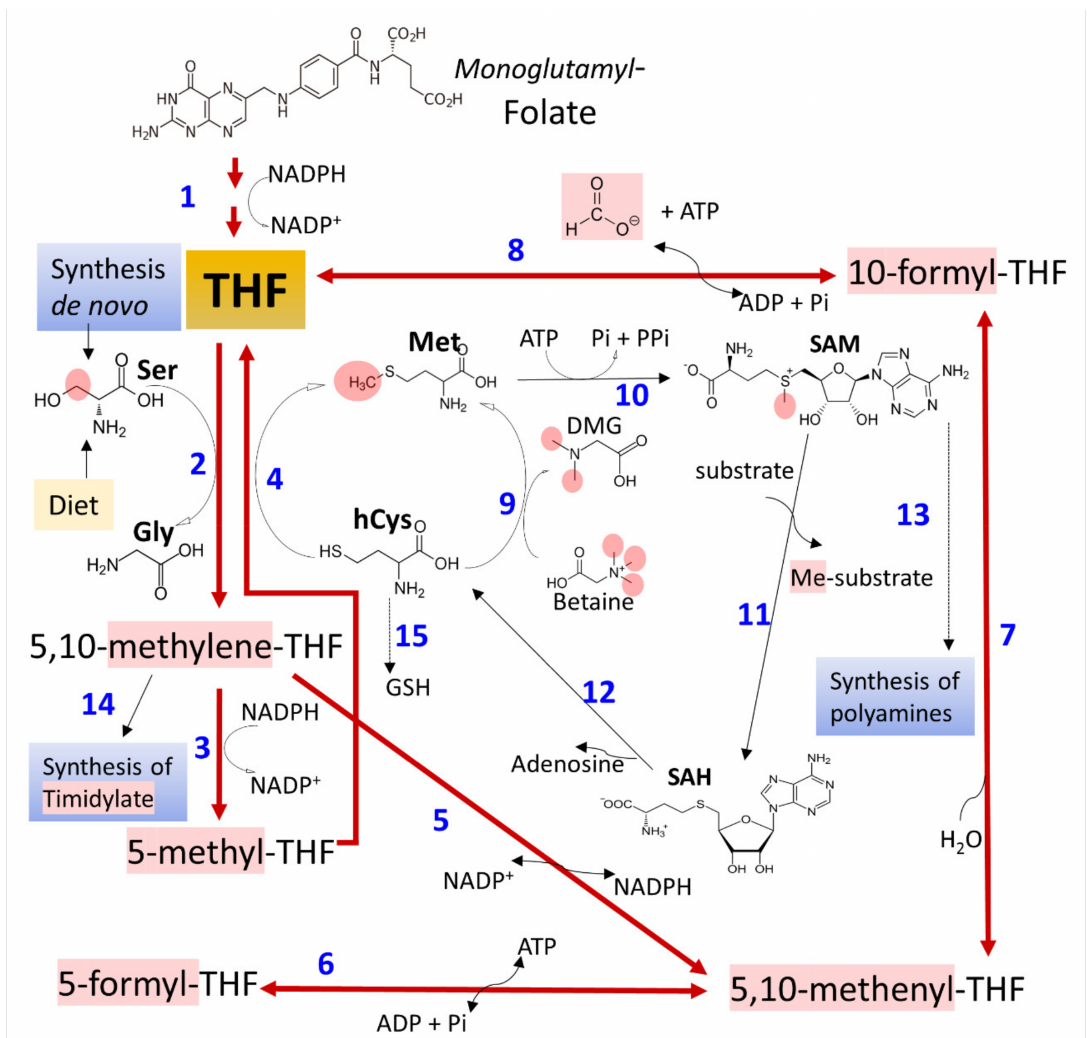
Figure 4. The hub of one-carbon metabolism pathways. The figure depicts the main routes involved in transferring one-carbon modules (highlighted in red) from one metabolite to another. 1, Dihydrofolate reductase, EC 1.5.1.3; 2,